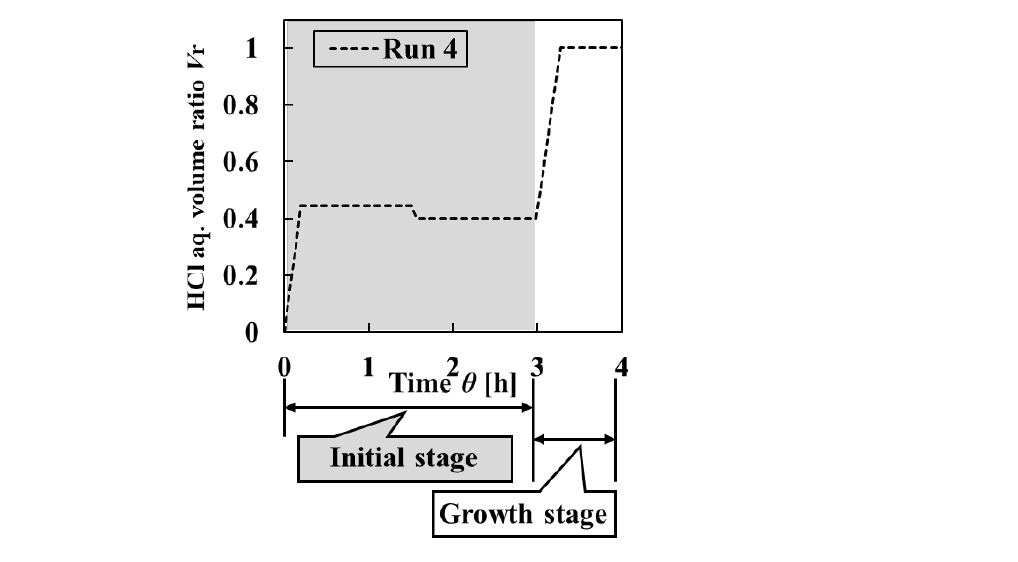
Figure 6. Change in HCl aq. volume ratio V r against the crystallization time in Run 4 with intermit- tent operation of HCl aq. with reverse addition of L-Asp aq.